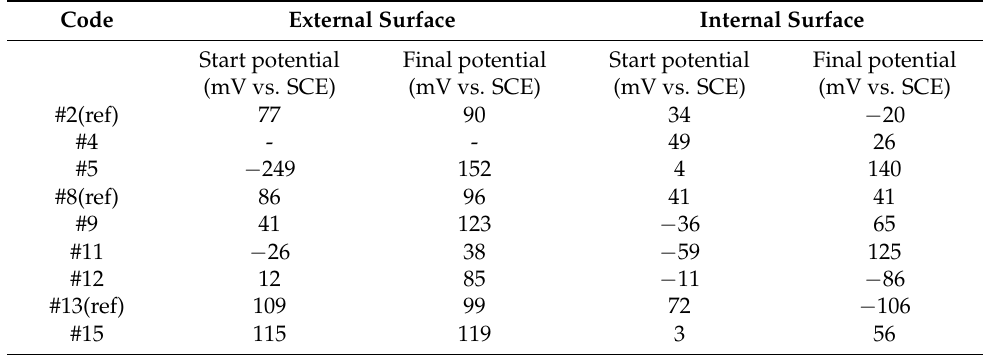
Table 6. The open circuit potentials measured at the start and at the end of each